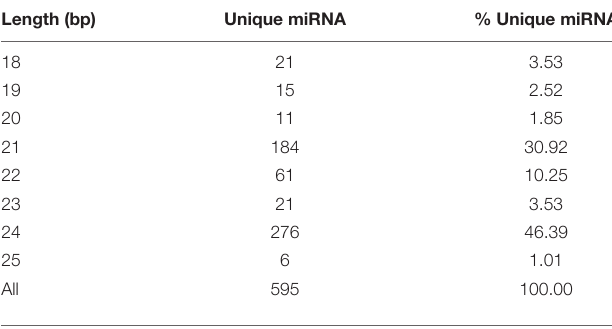
TABLE 4 | Length distribution of unique miRNAs.